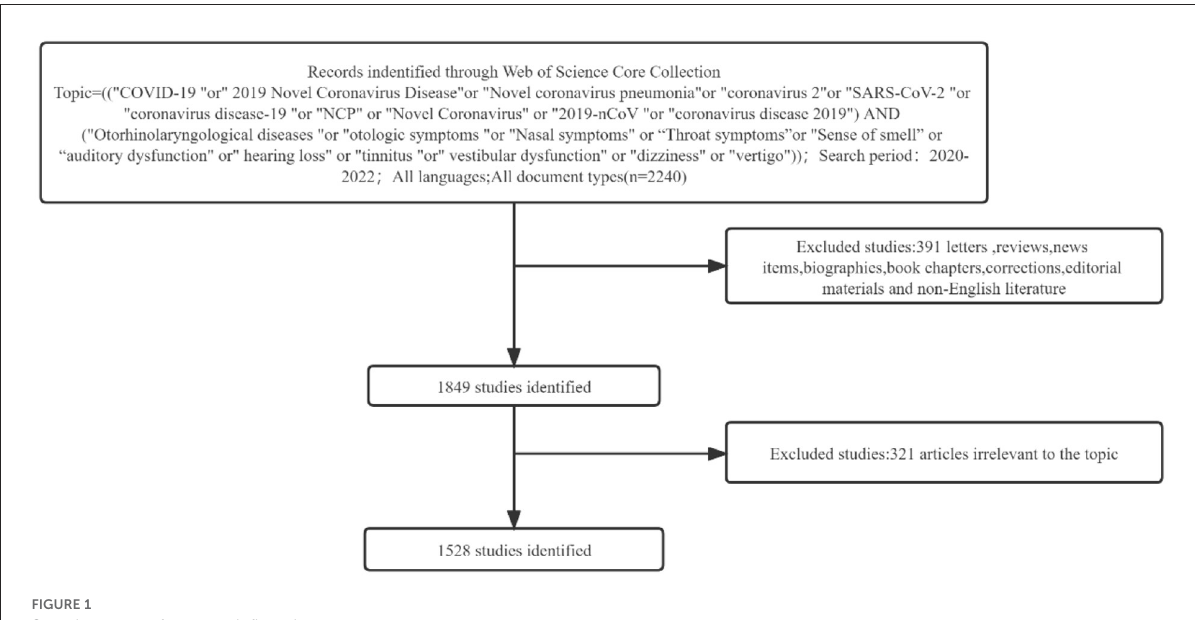
FIGURE1 Search strategy framework flowchart.